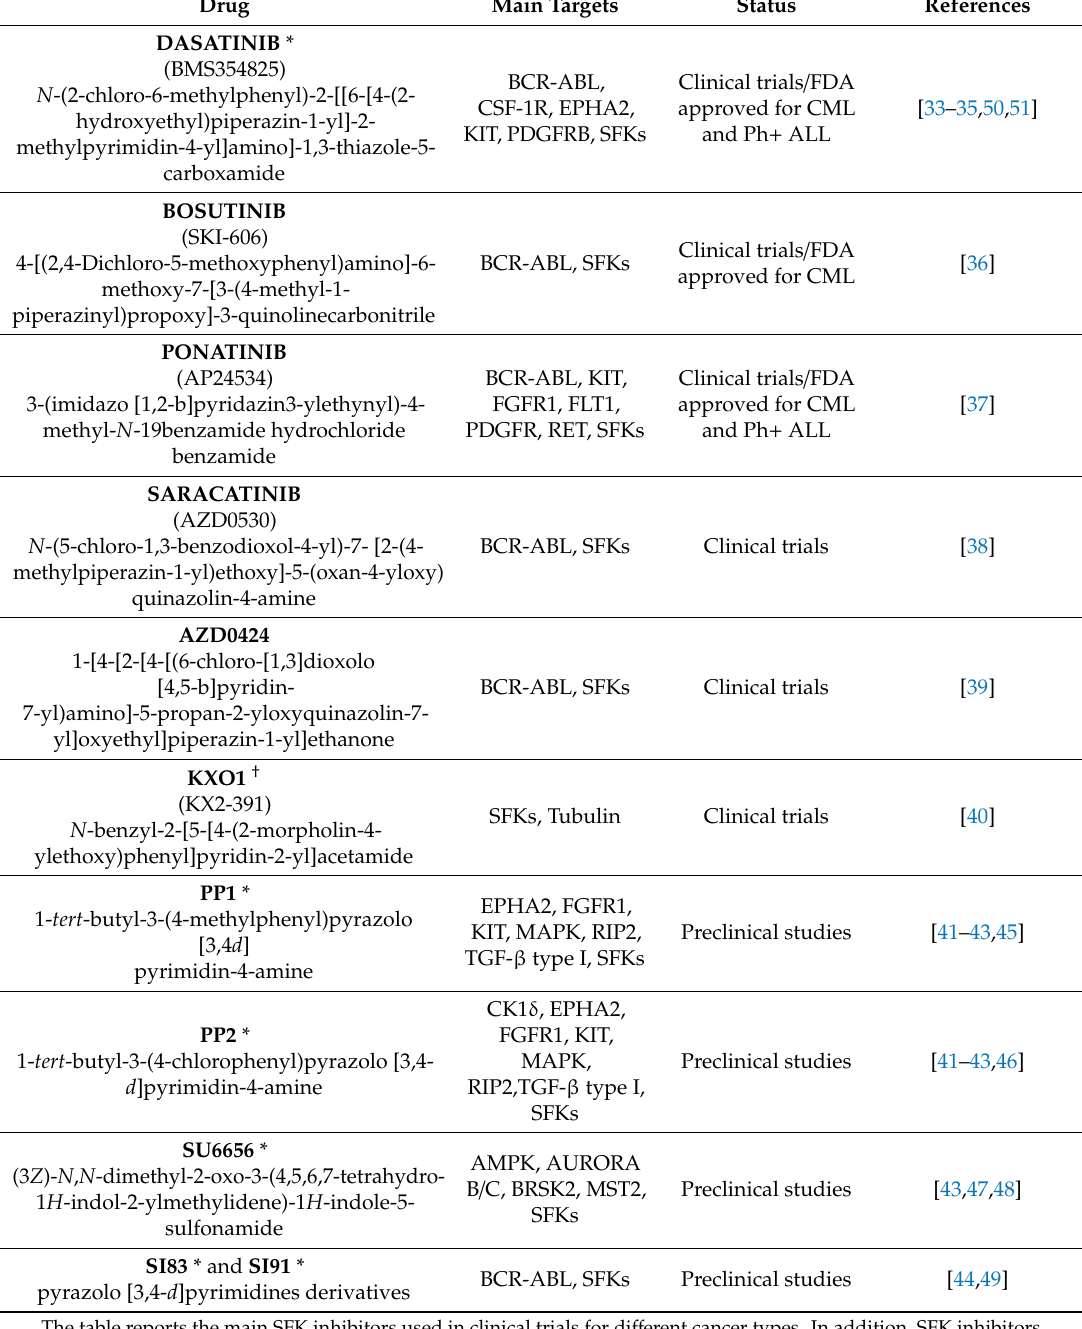
Table 1. Selected drugs targeting SFKs and other